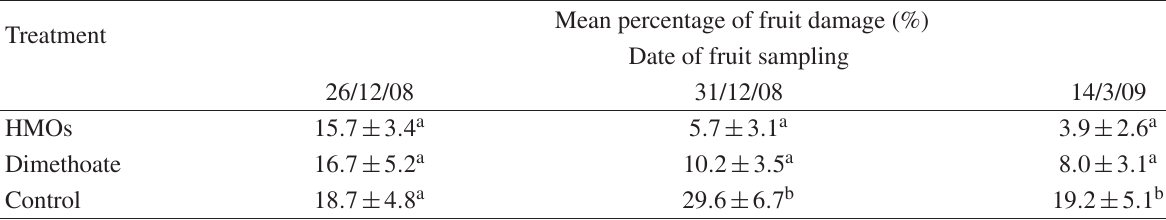
TABLE 2: Influence of n C24 Horticultural Mineral Oils (HMOs) Deposits and Synthetic Pesticide on Damage by Eudocima fullonia on Honey Mandarin during December 2008 and March